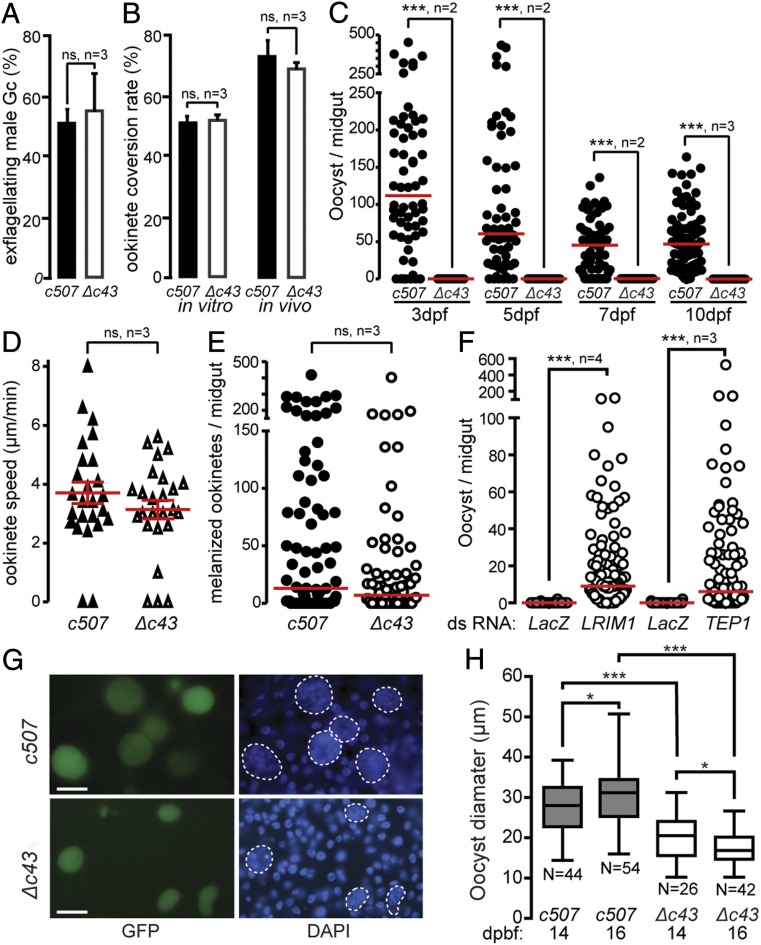
Phenotypic analysis of P. berghei Δc43 KO mutant parasites. Male gametocyte activation measured as percentage of exflagellating male gametocytes (A) and female gamete conversion to ookinetes in vitro (Left), and in vivo in the A. coluzzii midgut of (Right) (B) of c507 wt and Δc43 parasites. Error bars show SEM. (C) Δc43 oocyst development at 3, 5, 7, and 10 dpbf in A. coluzzii. ***P < 0.0001, Mann–Whitney U test. (D) Speed of c507 wt and Δc43 ookinetes measured from time-lapse microscopy, captured at one frame/5 s for 10 min. Red lines indicate mean and error bars show SEM. ns, not significant. (E) Melanized ookinete numbers in CTL4 kd A. coluzzii infected with c507 wt and Δc43 parasite lines. Red lines indicate median; ns, not significant; n, number of biological replicates. (F) Effect of LRIM1 and TEP1 silencing on Δc43 oocyst numbers in A. coluzzii midguts. dsLacZ-injected mosquitoes were used as controls. Red lines indicate median; n, number of independent experiments; ***P < 0.0001, Mann–Whitney U test. (G) Representative images of rescued Δc43 oocysts in LRIM1 KD mosquitoes showing variable morphology and smaller size compared to c507 wt oocysts. (Scale bars, 30 µm.) (H) Box plot of diameter measurements of Δc43 and c507 wt oocysts at 14 and 16 dpbf. Upper and lower whiskers represent the largest and smallest oocyst diameter, respectively. Horizontal line in each box indicates mean of 2 biological replicates and whiskers show SEM. N is number of oocysts; *P < 0.05, and ***P < 0.0001 using unpaired Student’s t test.